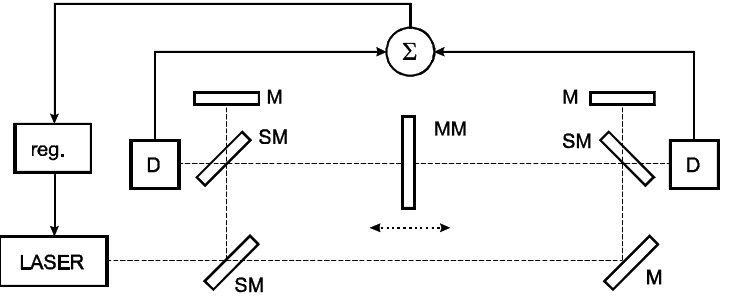
Figure 2. Principal schematics of the interferometric system with two countermeasuring Michelson Interferometers and stabilization of the laser wavelength to mechanical standard. D: detection unit, M: mirror, MM: movable mirror, SM: semireflecting mirror, reg.: